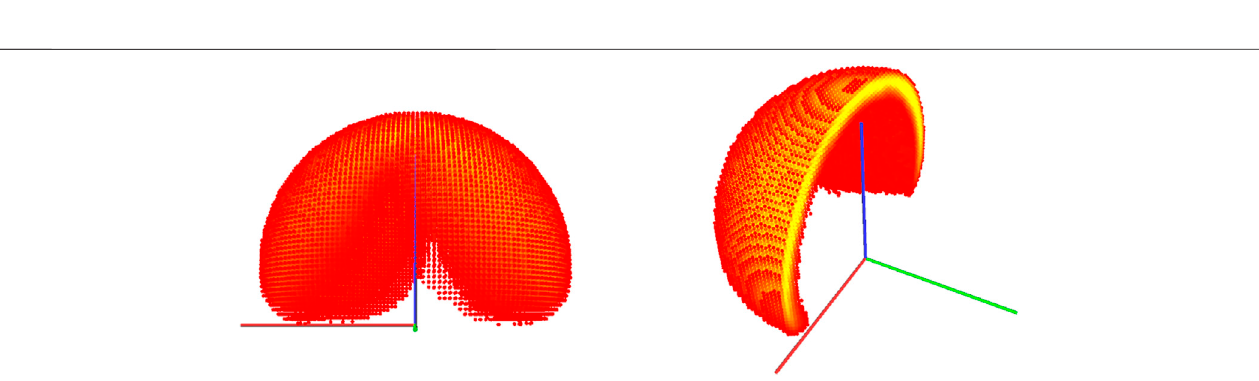
FIGURE 10 | Failure diagrams with one highlighted joint con fi guration (in yellow). Each row represents one joint (similar to Figure 9 ). The diagrams are not normalized as in Figure 9 , i.e the joint range spans from -180 to +180 deg. Regions that are out of the joint limits are represented as black cells. Top: Failure diagram showing all C-space manifold footprints. Bottom: Failure diagram showing only the C-space manifold footprint relevant for the current con fi guration.